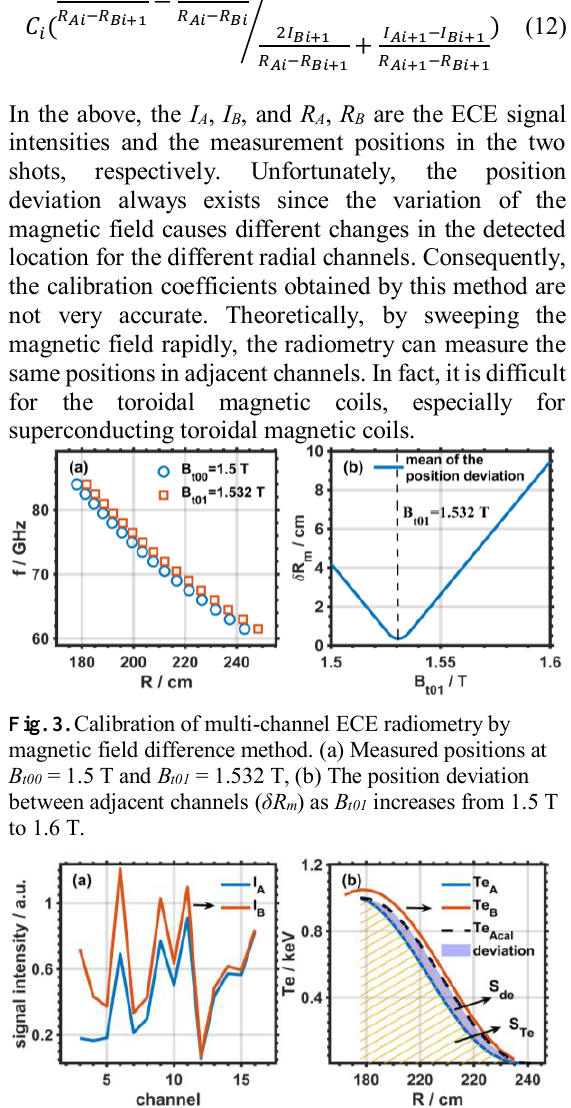
Fig. 4. Schematic diagram of the perturbation analysis of the magnetic field difference method. (a) The signal intensity of different channels. (b) Calibration results with the magnetic field difference method.